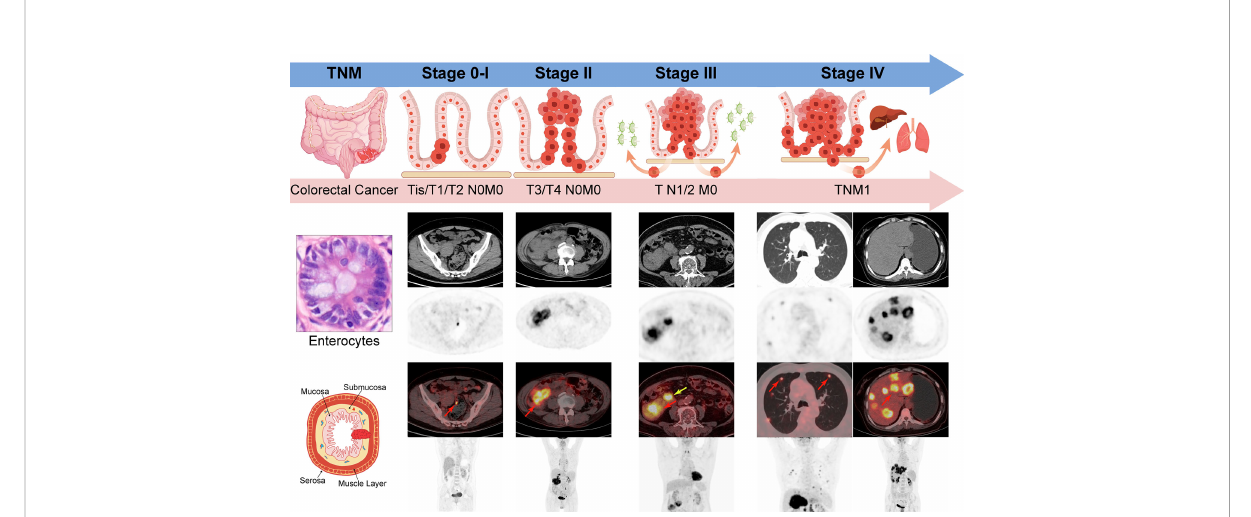
FIGURE 1 TNM stage of Colorectal cancer by AJCC 8th edition. Stage 0-I: Tumors spread within muscle layers without lymph nodes or distant deposits (Tis/T1/T2N0M0); Stage II: Tumors spread all layers or attached to nearby tissues without lymph nodes or distant deposits (T3/4N0M0); Stage III: Any T stage with the involvement of regional lymph nodes (TN1/2M0); Stage IV: Any T or N stage with distant metastasis (TNM1); Red arrow: the primary or metastatic tumors; yellow arrow: the metastatic lymph